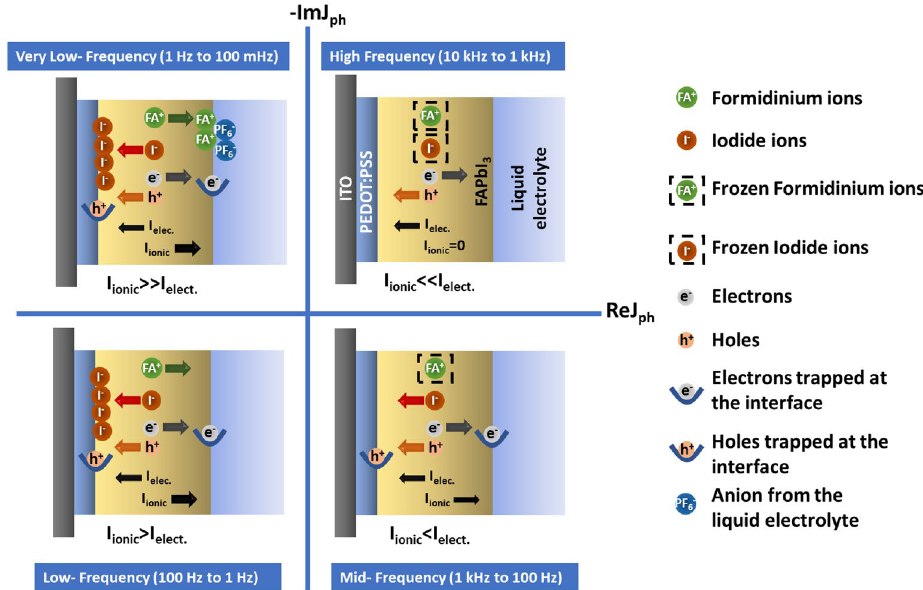
Figure 3. Schematics of electronic-ionic kinetics at different frequency leading to different feature in the four quadrants of Q-plane plot of perovskite–electrolyte interface.